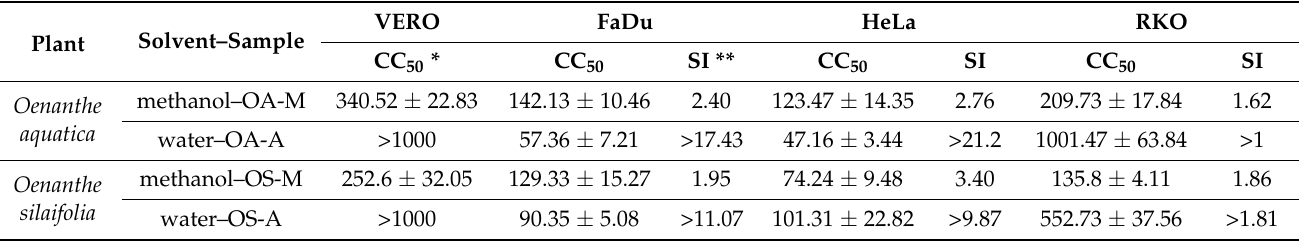
Table 5. Cytotoxicity of O. aquatica and O. silaifolia extracts.